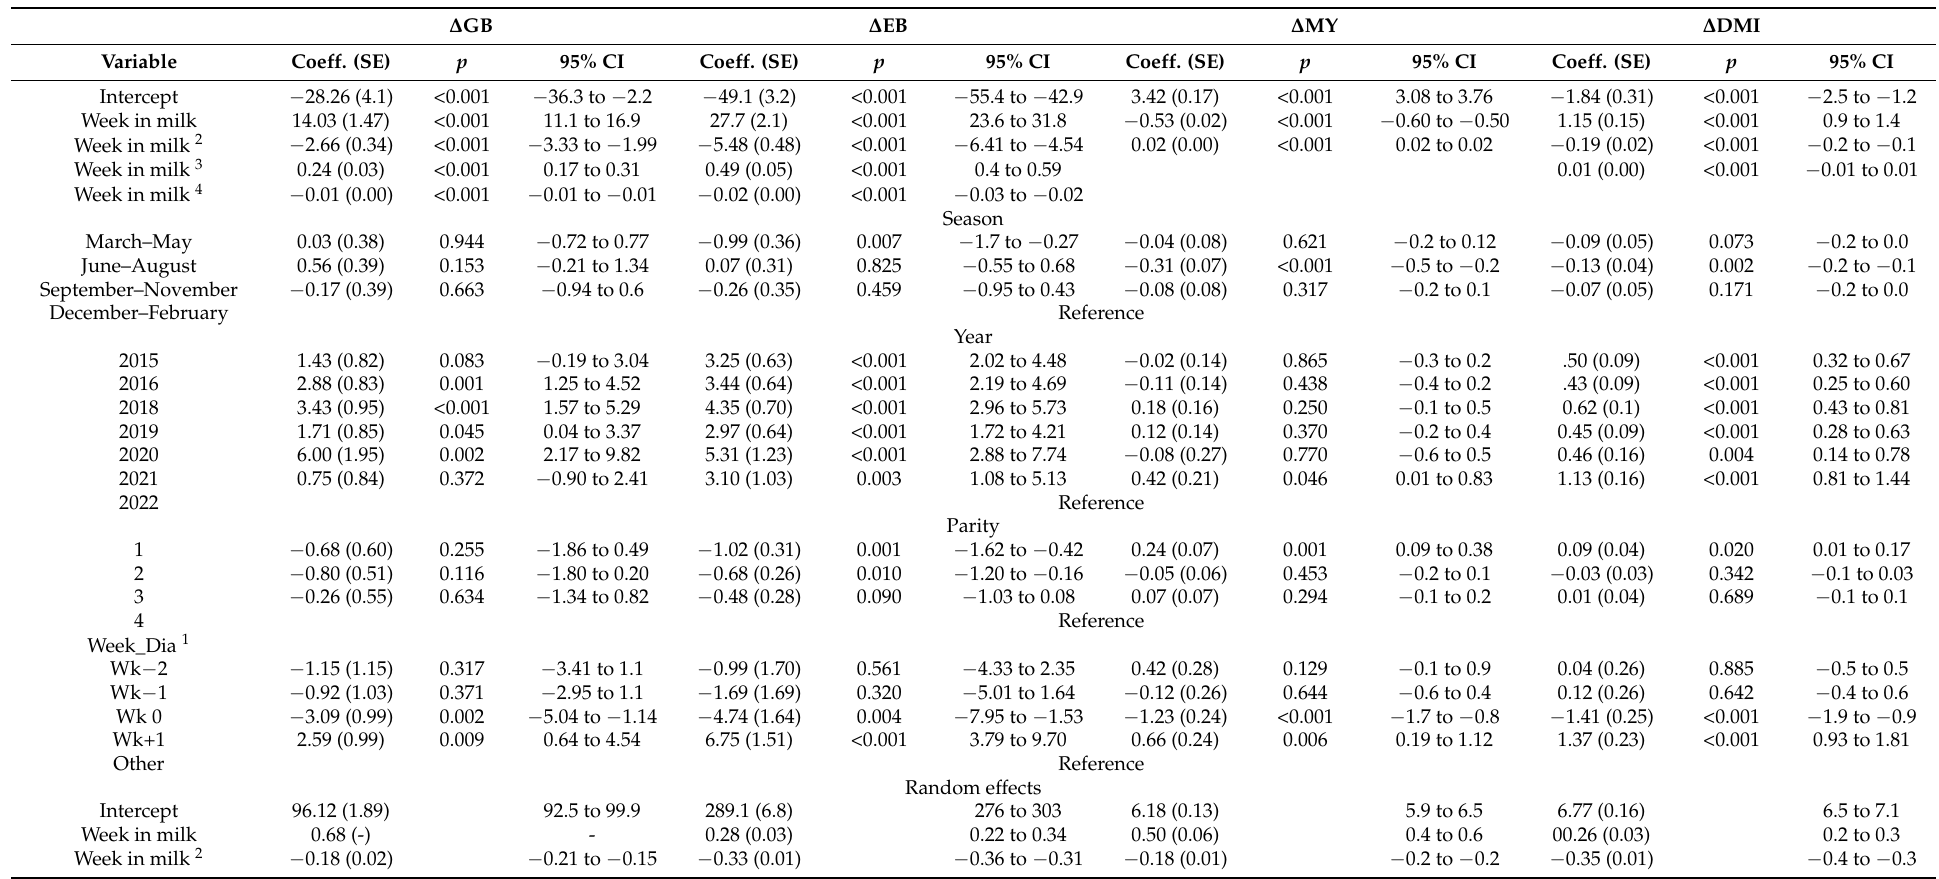
Table A1. Estimated regression coefficients and their standard errors from a mixed linear regression model of factors influencing the weekly change ( ∆ ) in